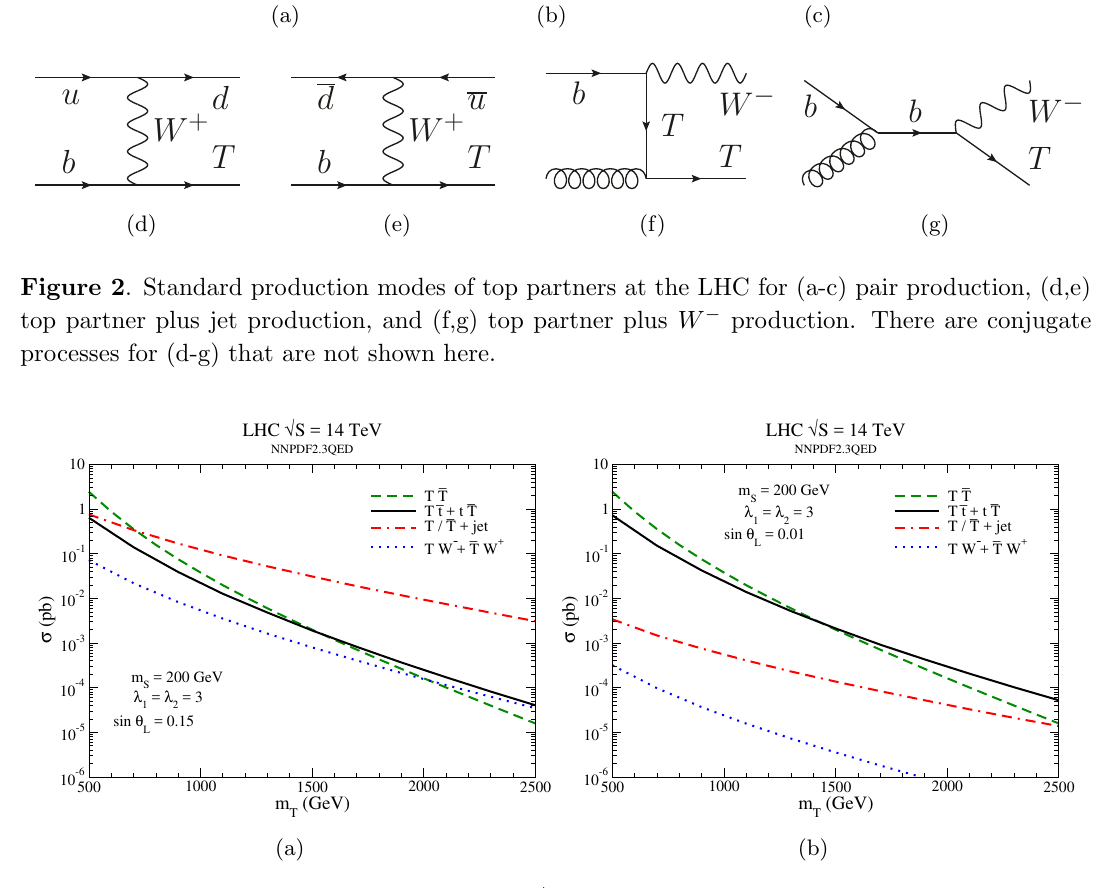
Figure 3 . Production cross sections at the p S = 14 TeV LHC for (green dashed) top partner pair production, (black solid) top partner production in association with a top quark, (red dash- dash-dot) top partner plus jet production, and (blue dotted) top partner plus W (cid:6) production. The parameters are set at a scalar mass m S = 200 GeV, couplings (cid:21) 1 = (cid:21) 2 = 3, and mixing angles (a) sin (cid:18) L = 0 : 15 and (b) sin (cid:18) L = 0 : 01. Factorization, (cid:22) f , and renormalization, (cid:22) r , scales are set to the sum of the (cid:12)nal state particle